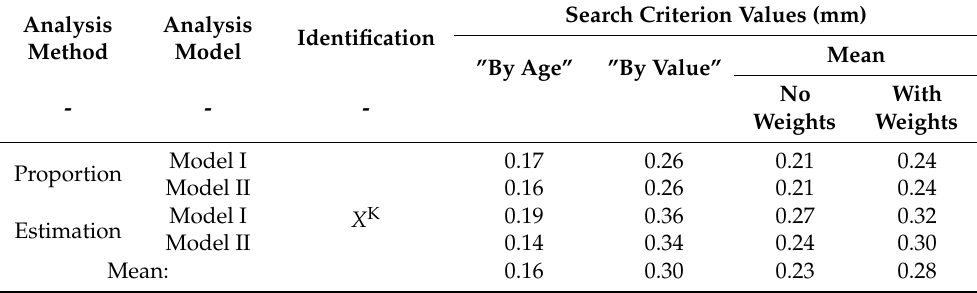
Table 11. Search criterion values for cement concrete.